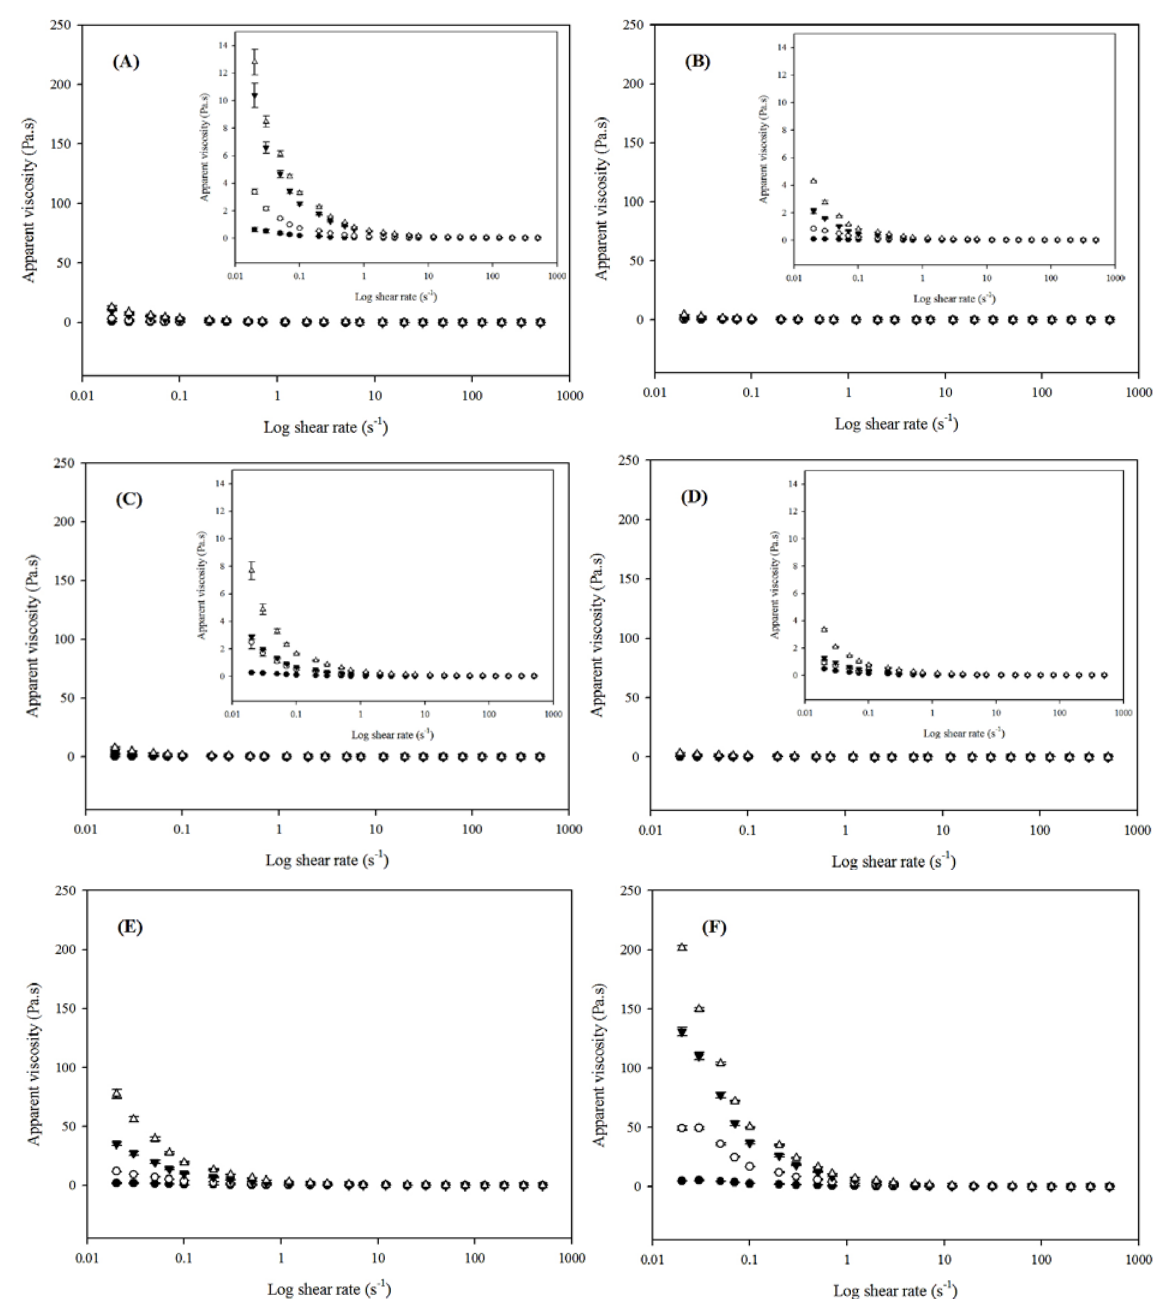
Figure 8. Apparent viscosity as a function of shear rate for different concentrations of xanthan gum and chia seed mucilage extracted by ultrasound in combination with heat. ( A ) Heat/Ultrasound-50 °C/30 min; ( B ) Heat/Ultrasound-50 °C/60 min; ( C ) Heat/Ultrasound-80 °C/30 min; ( D ) Heat/Ultrasound-80 °C/60 min; ( E ) Heat/Ultrasound-50 °C/60 min with purification; ( F ) xanthan gum. Error bars represent standard deviations (● 0.25%, ○ 0.5%, ▼ 0.75%, 1%).